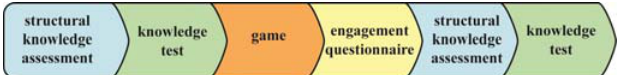
Figure 4. Procedure of the